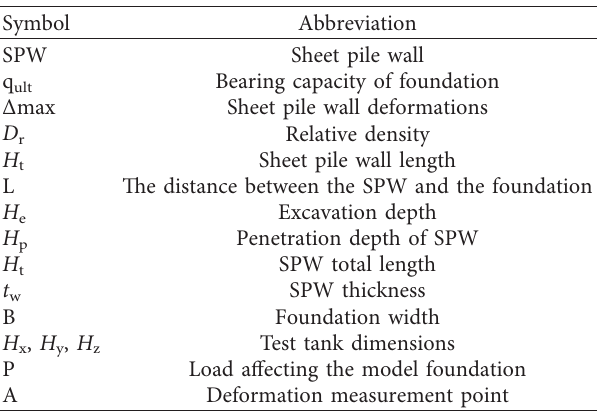
Figure 5: Cross-Sectional view of the test Table 4: Abbreviations.